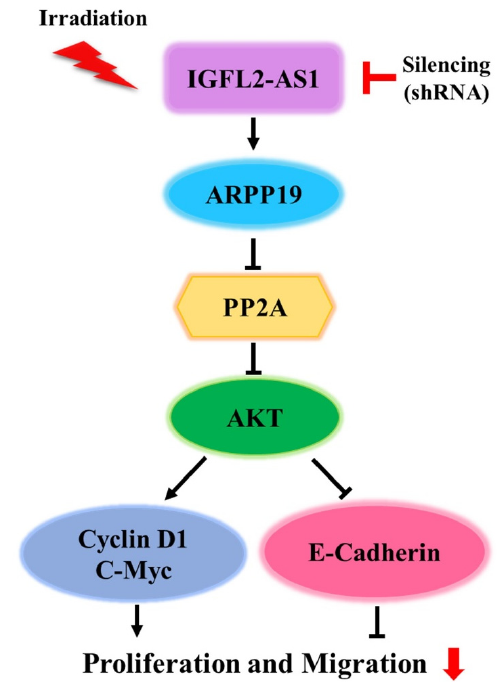
Figure 5. Schematic depiction of the sh-IGFL2-AS1 regulatory pathway. The current model of the association of IGFL2-AS1 with the acquisition of radioresistance in CRC. Various cancers differ in the molecular details by which the activity of the AKT pathway—the key signaling pathway in radioresistance—is enhanced. Therefore, many researchers have sought to develop AKT pathway inhibitors as a strategy for controlling radioresistance. However, the inherent toxicity associated with shutting down AKT activation has prevented the successful development of such radiosensitizers [13]. We showed that IGFL2-AS1 is new mechanism responsible for activating AKT signaling and conferring subsequent radioresistance. We believe that shRNA-based inhibition of AKT signaling could be a new approach for clinical applications. We would also note the potential of gene chip applications for measuring IGFL2-AS1 levels. Ultimately, our goal is to provide prognostic and diagnostic biomarkers and to improve the application and effectiveness of radiation therapy. 4. Materials and Methods 4.1. CRC Sample Preparation Samples from six pathologically proven CRC patients were included in the study. Outcomes of neoadjuvant chemoradiation therapy (NCRT) were categorized as complete response ( n = 3) or poor response ( n = 3) based on an analysis of total mesorectal excision specimens. The pathologic response was evaluated using the tumor regression grade (TRG) system suggested by the Gastrointestinal Pathology Study Group of the Korean Society of Pathologists [29]. The respective samples were collected from endoscopic cancers prior to neoadjuvant chemoradiation therapy and were subsequently processed as described previously [30].